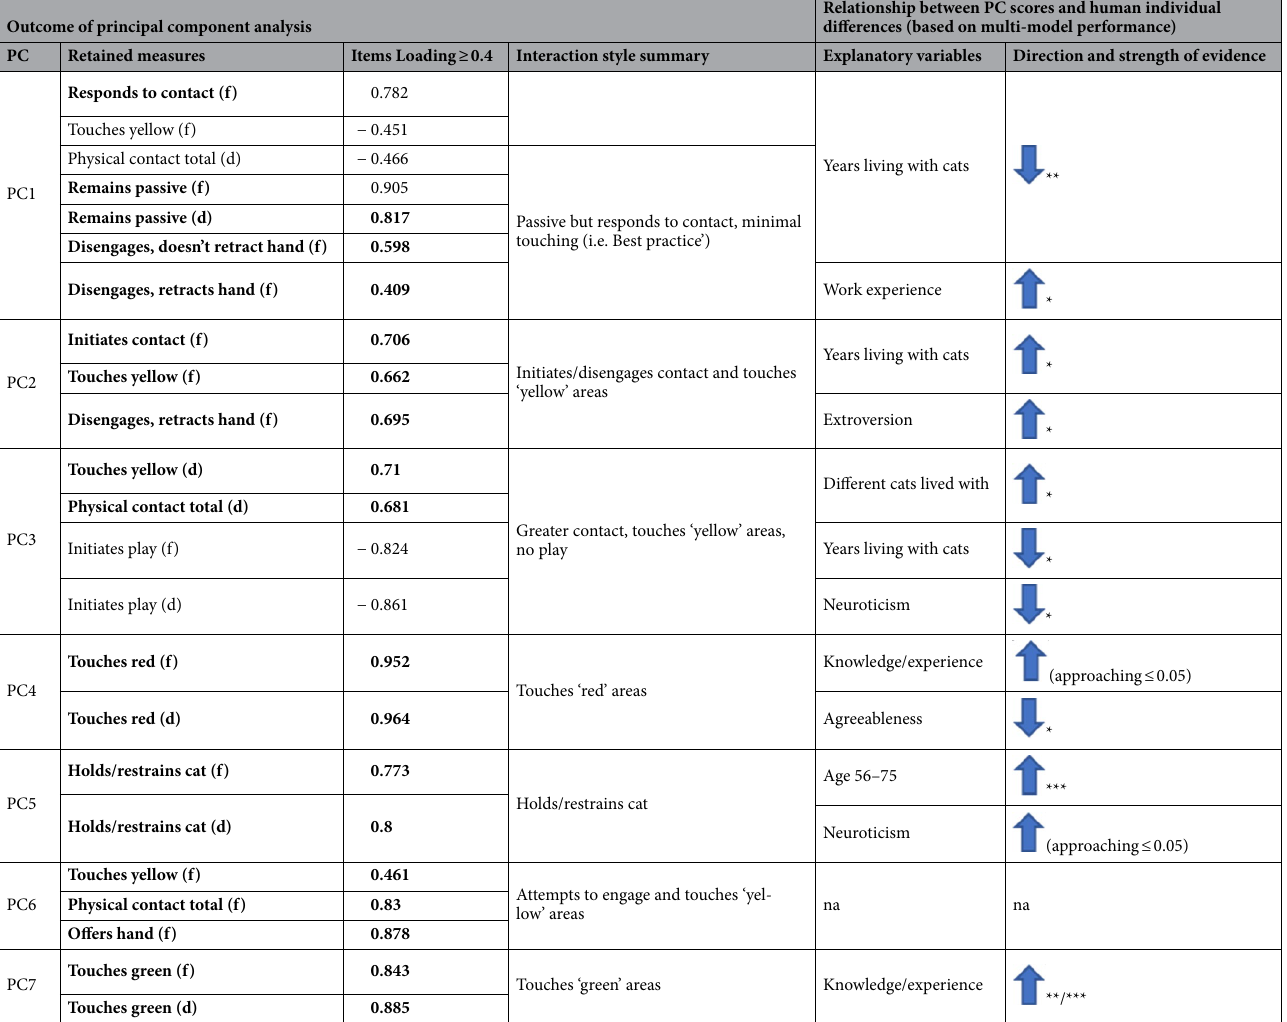
Table 2. Summary table including PC components retained, item contents for each PC, their loadings and PC summary in relation to humans’ interactions styles. Items in bold signify positive loadings. PC relationships with individual explanatory variables, direction of effects and strength of evidence (* p < 0.05, ** p < 0.01, *** p < 0.001) are also presented. For full details of model performance and outputs from top 3 ranked GLMs for each PC, see Supplementary File